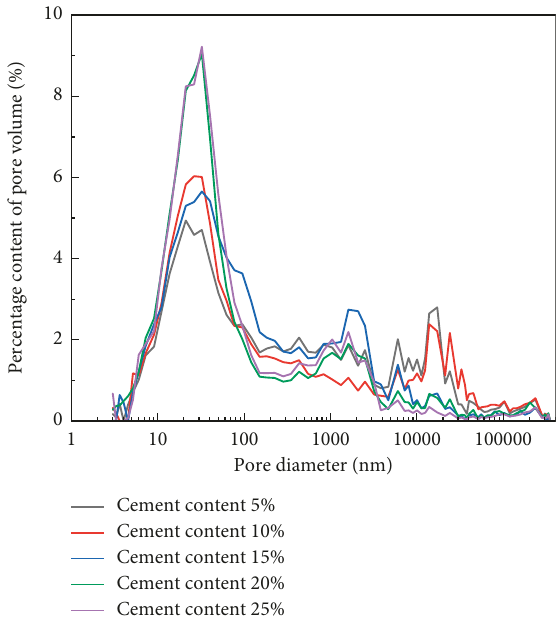
Figure 13: Distribution curve of pore size and pore percentage under different cement ratios.